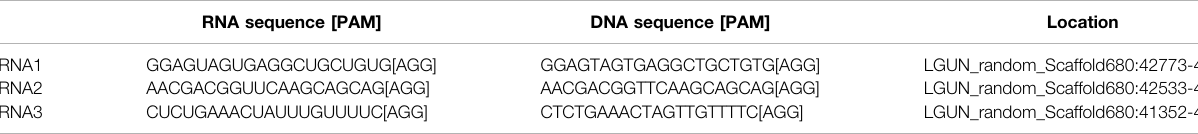
TABLE 1 | sgRNAs designed to target the homeobox 2.5 Nkx of B. glabrata .